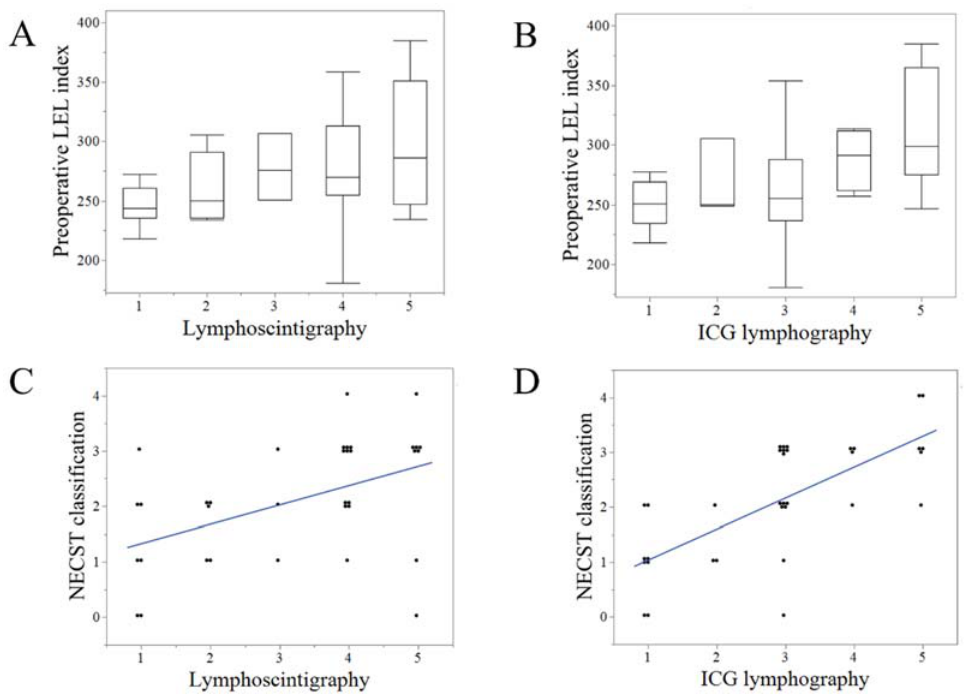
Figure 5. Correlation between the clinical severity staging of lymphedema and lymphoscintigraphy and ICG lymphography. The preoperative LEL index exhibited a mild correlation with lymphoscintigraphy (r = 0.35, p = 0.03) ( A ) and moderate correlation with ICG lymphography (r = 0.45, p < 0.001). ( B ) The normal, ectasis, contraction, and sclerosis type classification (NECST) exhibited a strong positive correlation with ICG lymphography (r = 0.72, p < 0.001) ( C ) and a moderate correlation with lymphoscintigraphy (r = 0.47, p < 0.01) ( D ). ICG, indocyanine green; LEL, lower extremity lymphedema.